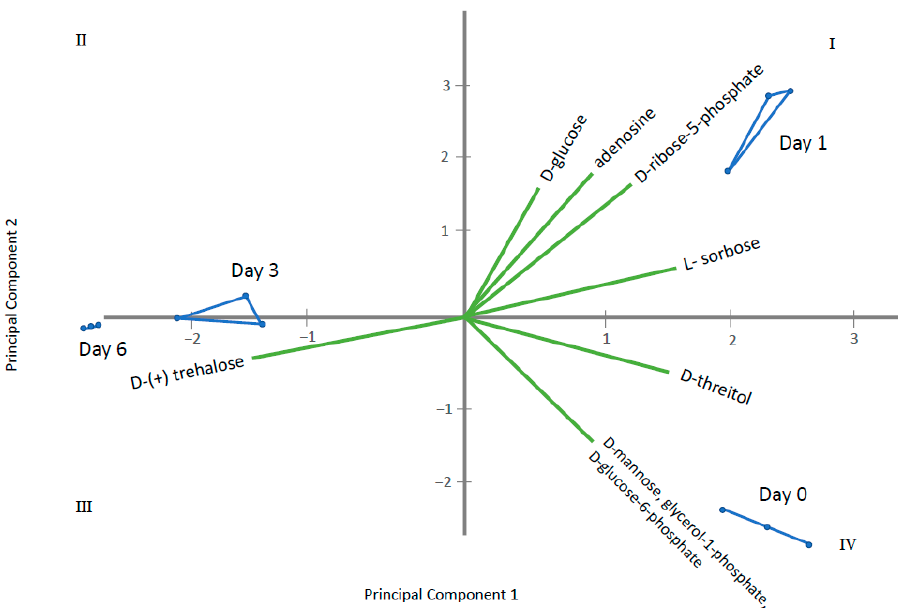
Figure 6. Principal Component Analysis (PCA) for fatty acids where Principal Component 1 displays 98.4% of the varia- bility and Principal Component 1 for 1.4%. The green vectors represent each metabolite, whose projection of the vertex on each axis represents its contribution to each PC. The blue points are each sampling time replicate, connected by lines to represent the PC scores of the samples analyzed.